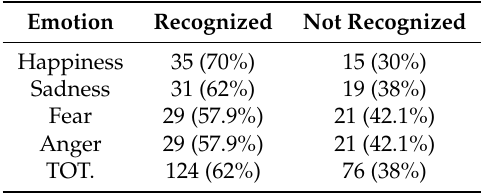
Table 4. Scores achieved by the typically developing (TD) group in the Facial Emotion Recognition (FER) task.